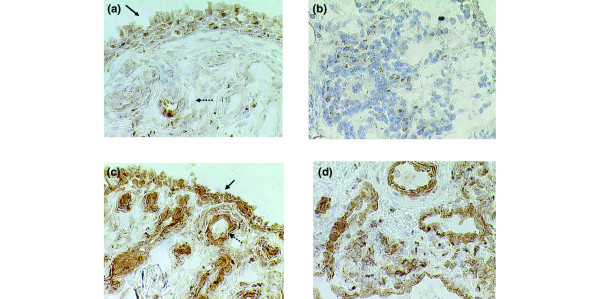
IL-15 is present in synovial tissue in rheumatoid arthritis before and after treatment with infliximab. Sections of synovial biopsy tissue from patient no. 5 show diaminobenzidine staining (haematoxylin counterstained) for IL-15 neutralizing antibody before (a) and after (b) treatment with infliximab, and for IL-15 non-neutralizing antibody before (c) and after (d) treatment with infliximab. In (a) and (c) solid arrows indicate synovial lining layer and dotted arrows indicate endothelial cells. Original magnification × 250.